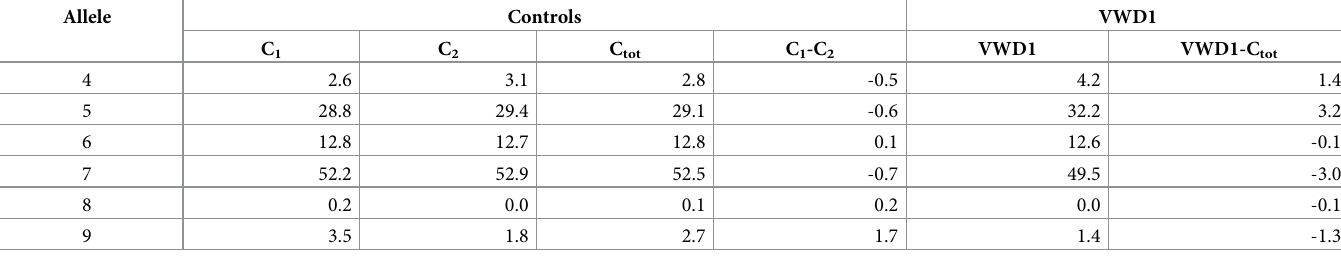
Table 3. CLEC4M VNTR allele frequencies in Swedish type 1 VWD patients and controls.